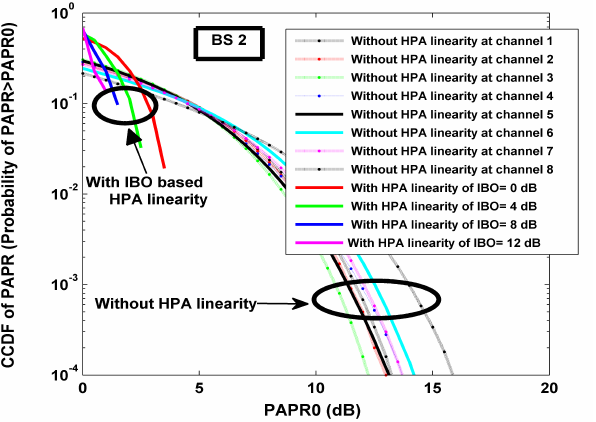
Figure 14. CCDFs of PAPR for the considered system with and without the utilization of IBO − aided PAPR scheme at BS 2.